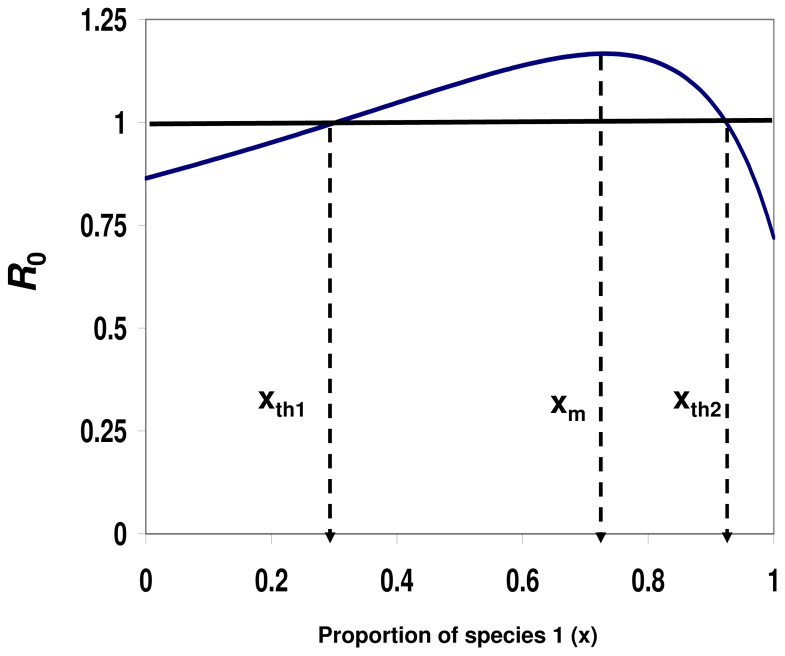
Diversity amplification - R
0(x) is hump-shaped as a function of host diversity.The figure depicts R0 as a function of x, the proportion of host species 1 in the community. The behavior of R
0(x) depends on the values of the vector preference, α, and the transmission ratio, γ. The preference and the transmission ratio in this case are, α = 3.3 and γ = 1.2 (equation 8b), respectively, i.e., species 2 is both, the preferred host and a superior transmitter of the disease. Under such conditions, R0(x) is hump-shaped with a maximum at x = xm =  0.730 (equation 9). Disease eruption is possible only for R0>1, i.e., when the proportion of species 1, x, is in the range xth
1 =  0.31 <x<0.94 = xth
2, or alternatively, when the proportion of the superior host (by both measures; transmission ability and preference), species 2, is between 0.06 and 0.69. Other parameter values are: V = 100, N = 2500, g
1 = 0.01, k = 3, and d = 0.05.